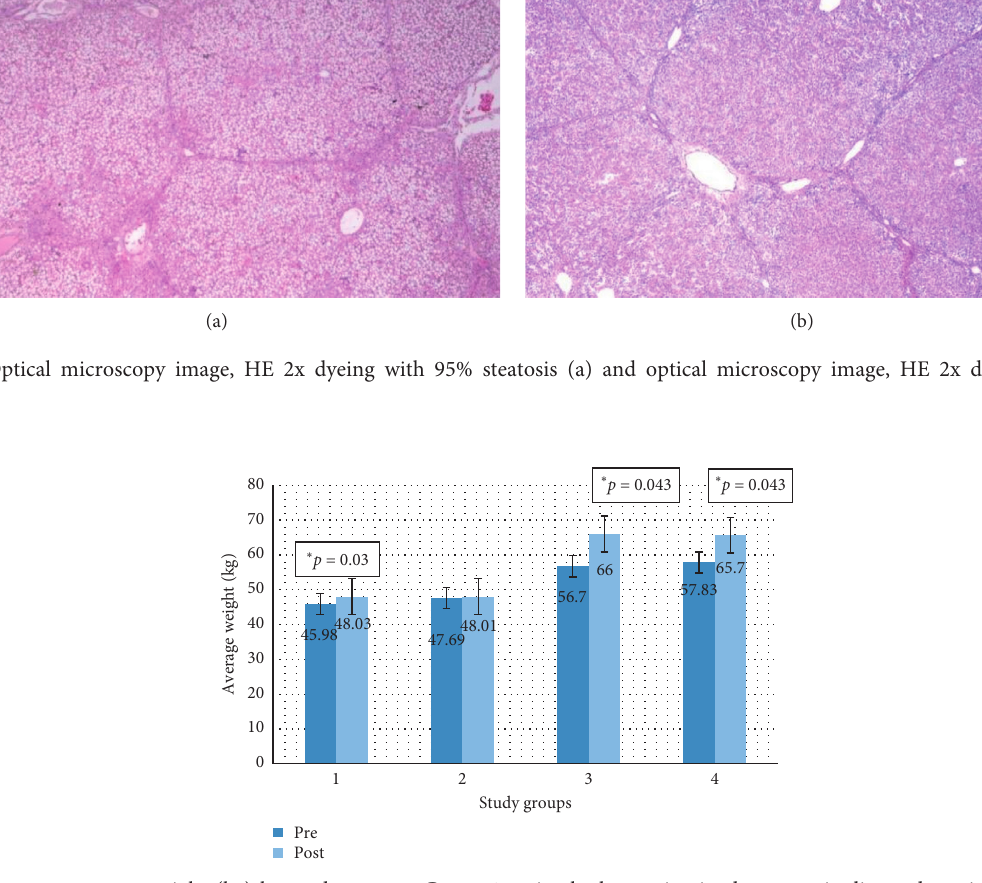
Figure 3: Average pre-post weight (kg) by study groups. Group 1: animals that maintained a steatotic diet and received concomitant treatment. Group 2: animals that maintained a steatotic diet and received no drug. Group 3: animals that did not continue with the steatotic diet but received melatonin treatment. Group 4: animals that did not continue with the steatotic diet and did not receive any drug.